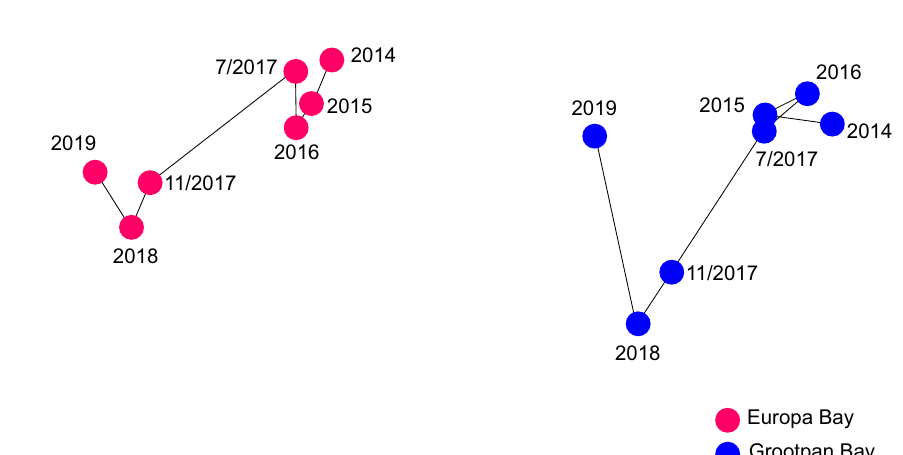
Figure 5. MDS ordination based on colony size frequency structure at Grootpan Bay and Europa Bay over seven samplings between 2014 and 2019. Separation along the abscissa is most strongly determined by membership of the four largest size classes (i.e., colonies ≥ 10 cm in height, II-V), whereas separation along the ordinate is most strongly determined by membership of the < 10 cm size class (I). Data were square root transformed prior to analyses, and the resemblance matrix was prepared using Bray Curtis